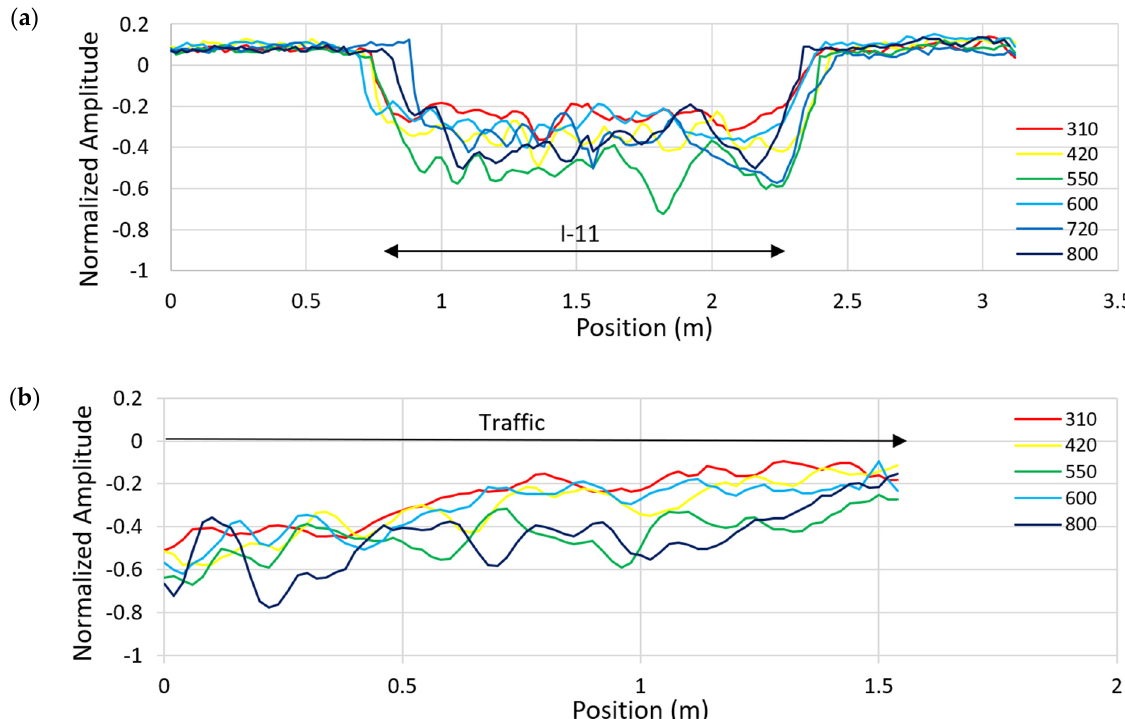
Figure 19. 5 GHz Norm. RW amplitudes on sand (I-11) in the ( a ) long. and ( b ) transv. direction vs. K loadings.